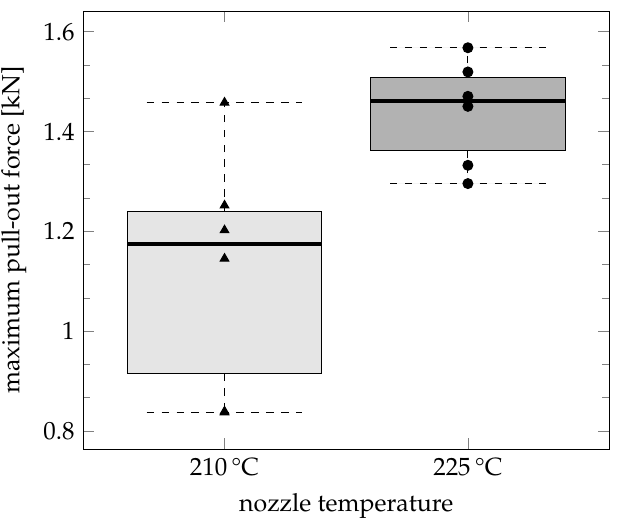
Figure 16. Maximum pull-out forces for variations of the nozzle temperature (six specimens